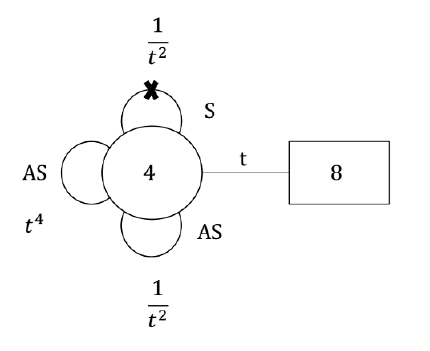
Figure 2. The 4 d theory conjectured to be the result of the compacti(cid:12)cation and mass deformation of the rank 2 E-string. Here the gauge group is USp(4) and S and AS denote the symmetric, that is the adjoint for USp groups, and antisymmetric representations, respectively. Here there is a superpotential coupling the symmetric chiral to the quark bilinear and the middle antisymmetric to the symmetric bilinear. The theory has an SO(8) global symmetry represented by the square as well as a U(1) whose charges we denoted using the fugacity t . The black X on the symmetric chiral stands for an additional chiral (cid:12)eld which couples linearly to the symmetric bilinear. In fact, due to the charges of the (cid:12)elds, the (cid:13)ip (cid:12)eld also couples linearly to the lower antisymmetric bilinear, and so e(cid:14)ciently (cid:13)ips some combination of the two symmetric bilinears. There is also an anomaly free R symmetry under which the symmetric and lower antisymmetric have R charge 0, the quarks R charge 1 and the middle antisymmetric and (cid:13)ip (cid:12)elds have R charge